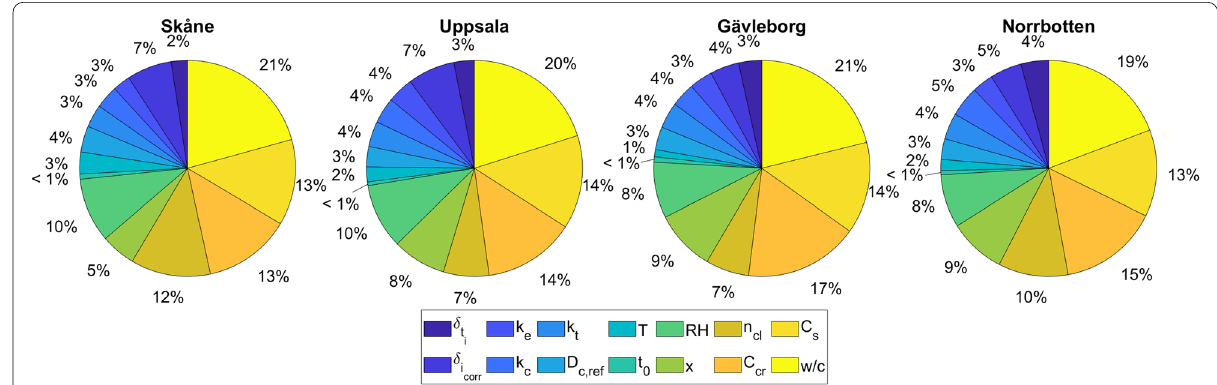
Fig. 13 The sensitivity of the mean value of the end-of-century corrosion rate to the different input